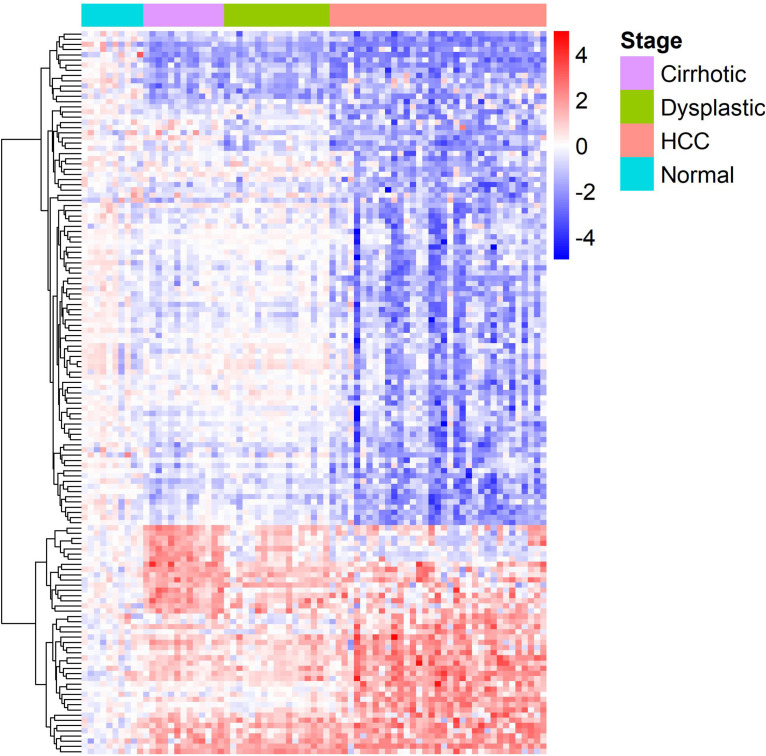
A heat-map for the differentially expressed lipid metabolic genes. Rows and columns represent genes and samples, respectively, and gene names are given in Supplementary Table S1. Expression values of each gene were centralized at the mean of normal samples and divided by the standard deviation of all samples.